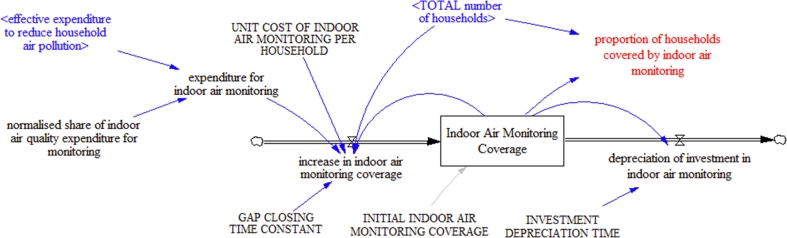
Formulation of indoor air monitoring coverage.